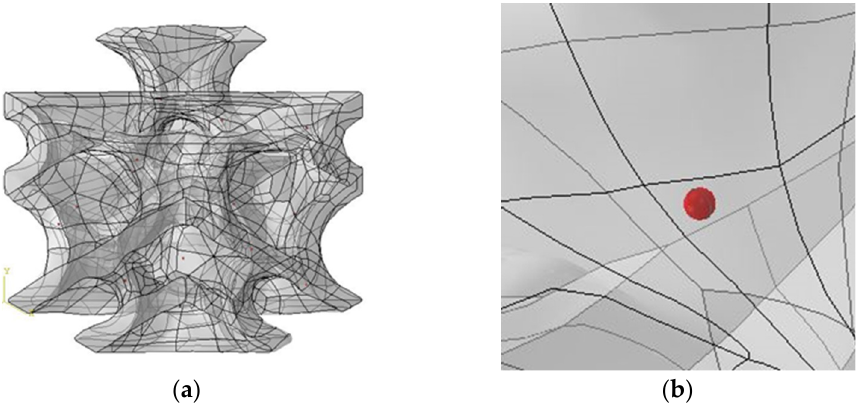
Figure 6. D structure diagram considering voids of ( a ) finite element model and ( b ) enlarged view of a local area with voids.